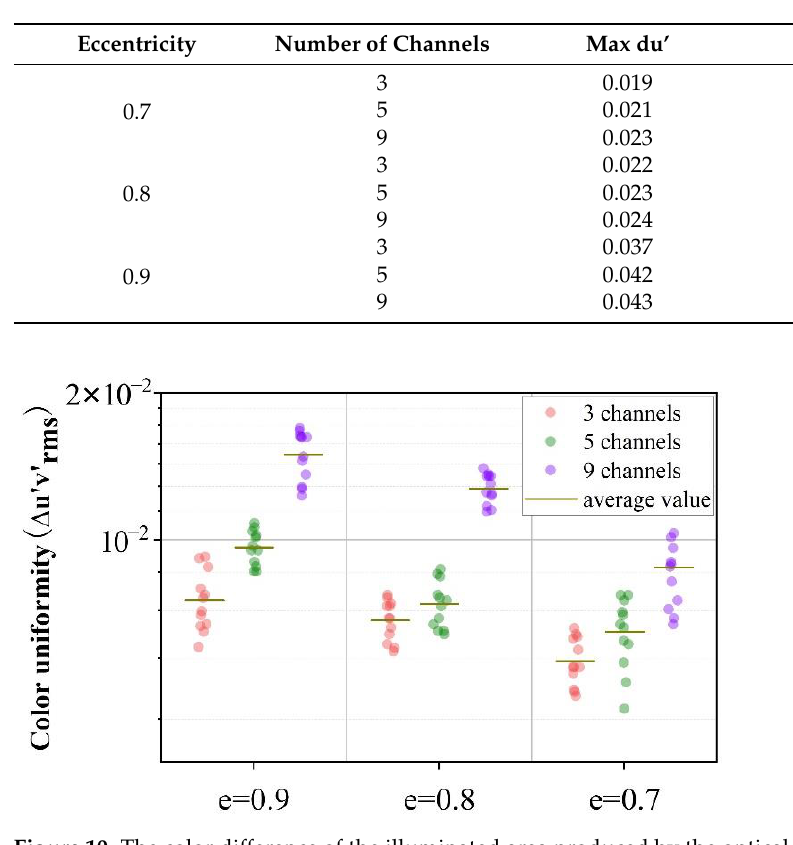
Figure 10. The color difference of the illuminated area produced by the optical systems.